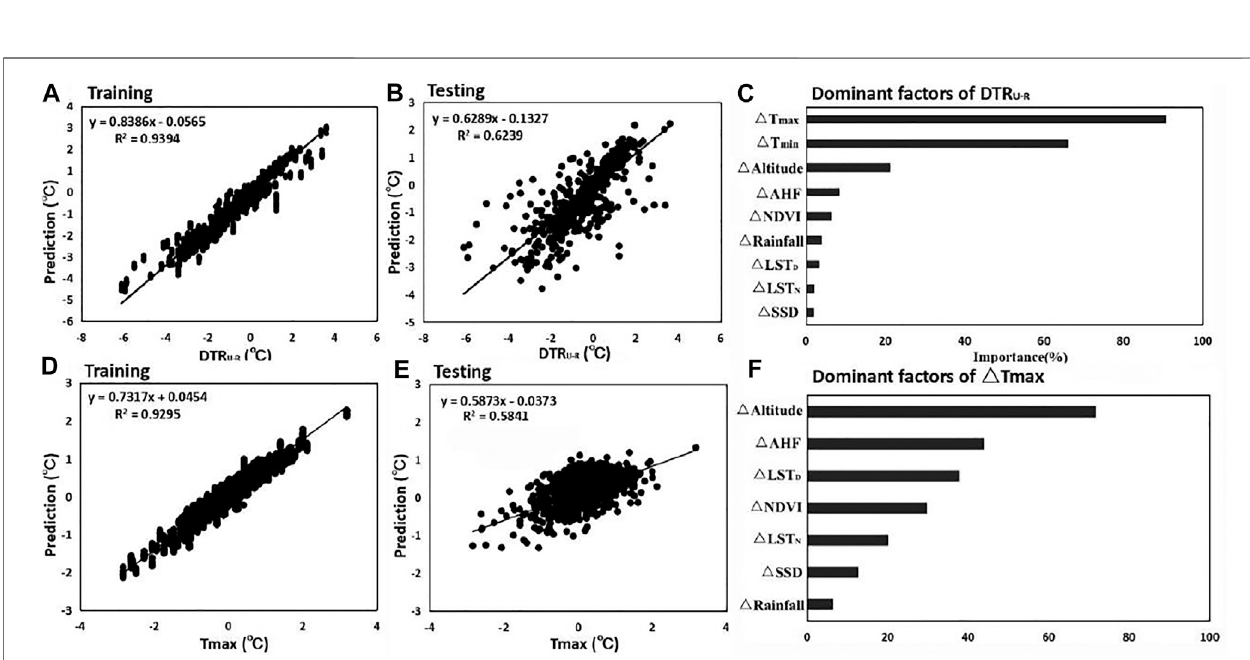
FIGURE7| ProbabilitydensitydistributionsofDTRaturbanandruralstationsintheurbanagglomerationoftheYangtzeRiverDeltaregionin (A) June, (B) July,and (C)